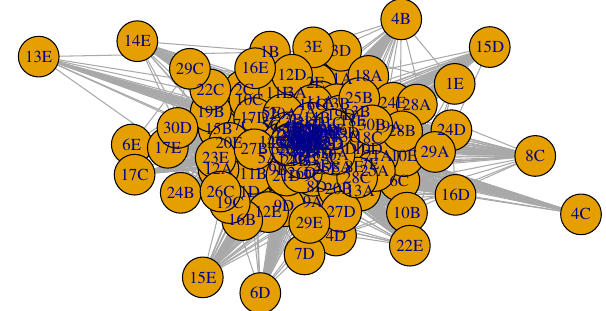
FIG. 2. Unipartite network for the FCI post-test responses of